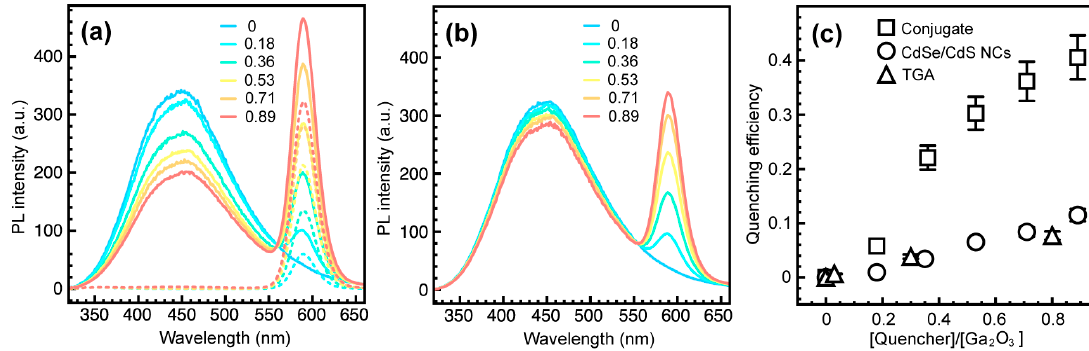
Figure 4. ( a ) PL spectra of colloidal Ga 2 O 3 -CdSe/CdS NC conjugates (solid lines) having different CdSe/CdS to Ga 2 O 3 NC concentration ratio, as indicated in the graph. PL spectra of thioglycolic acid (TGA)-bound CdSe/CdS NC suspensions having the same concentration as in the NC conjugate are shown with dashed lines ( λ exc = 250 nm); ( b ) PL spectra of the mixtures of Ga 2 O 3 and CdSe/CdS NCs prepared in the same way as the NC conjugate but without the TGA linker; ( c ) Quenching efficiency of the donor-acceptor pair (DAP) emission of Ga 2 O 3 NCs in the conjugate (squares), mixed with CdSe/CdS NCs (circles), and mixed with TGA but without CdSe/CdS NCs (triangles).